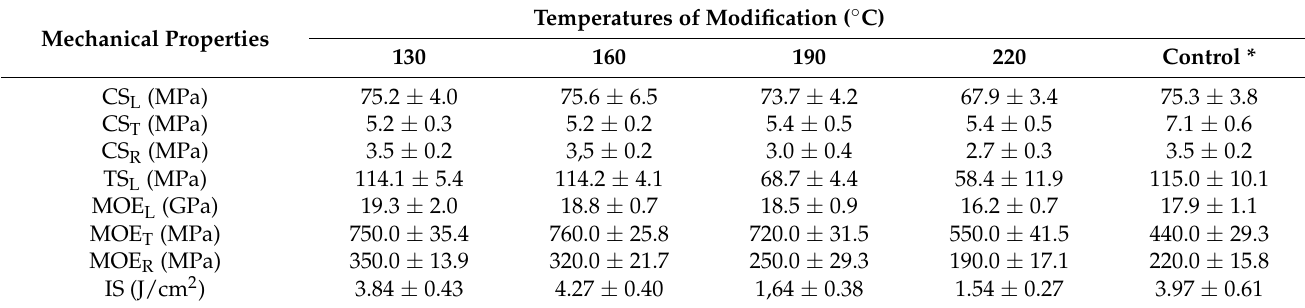
Table 2. Mechanical properties of wood.